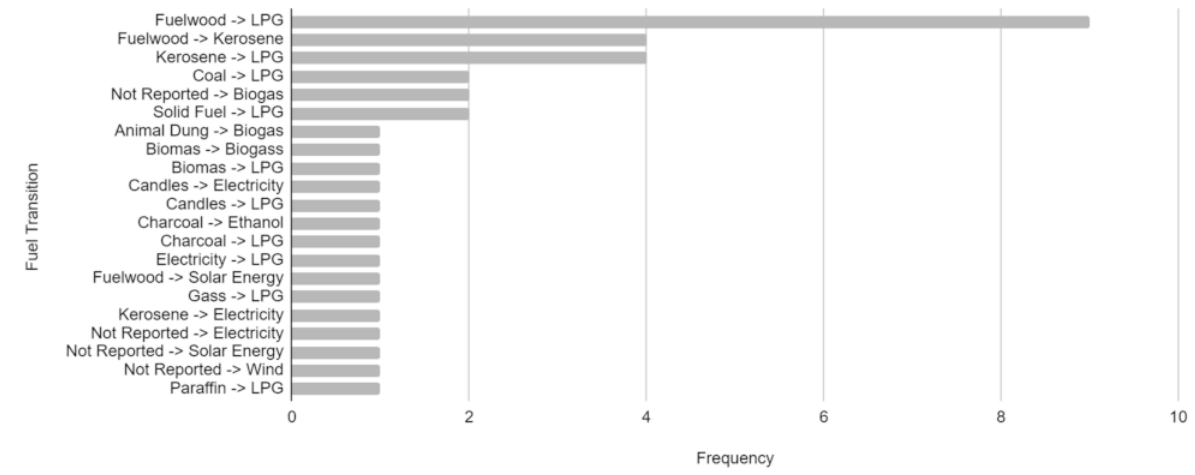
Figure 11. Characteristics of fuel use and transitions from evidenced programmes.